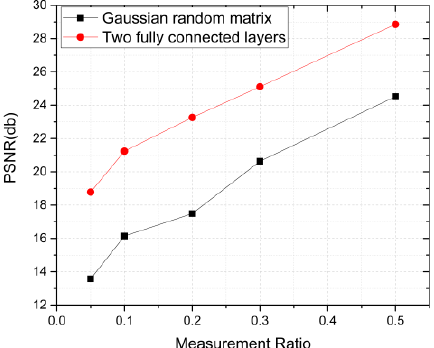
Figure 9. Some images generated by DPAP with a measurement rate of 0.1 at different number of iterations.